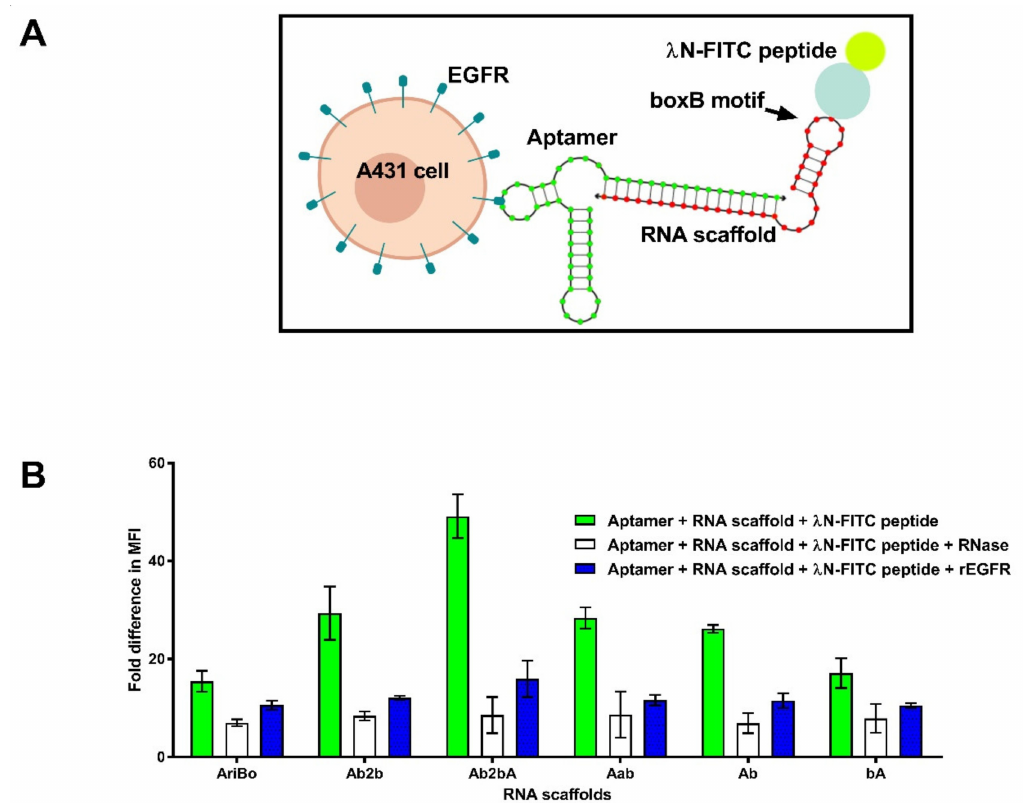
Figure 4. Testing of RNA scaffolds designed to bind the J18 Rvs aptamer and the bacteriophage λ N protein. ( A ) Outline of the scaffold binding approach involving the J18 Rvs aptamer and the λ N-FITC peptide. ( B ) Binding of aptamer/scaffold/ λ N- FITC peptide complexes to the A431 cells analyzed by flow cytometry. The green bars refer to the binding to the A431 cells of the J18 Rvs aptamer in combination with an RNA scaffold and the λ N-FITC peptide. The open bars refer to samples treated with ~0.02 U/ µ L of RiboShredder RNase blend prior to flow cytometry. The blue bars refer to the samples treated using rEGFR (1 µ M). The binding of the aptamer/scaffold/ λ N-FITC complexes to the cells was carried out as described in Section 4. The fold differences in MFI refer to the MFI signal obtained with a particular aptamer/scaffold/ λ N-FITC peptide complex compared to the MFI signal observed with the cells treated with λ N-FITC peptide alone. The error bars represent mean ± SD of two independent